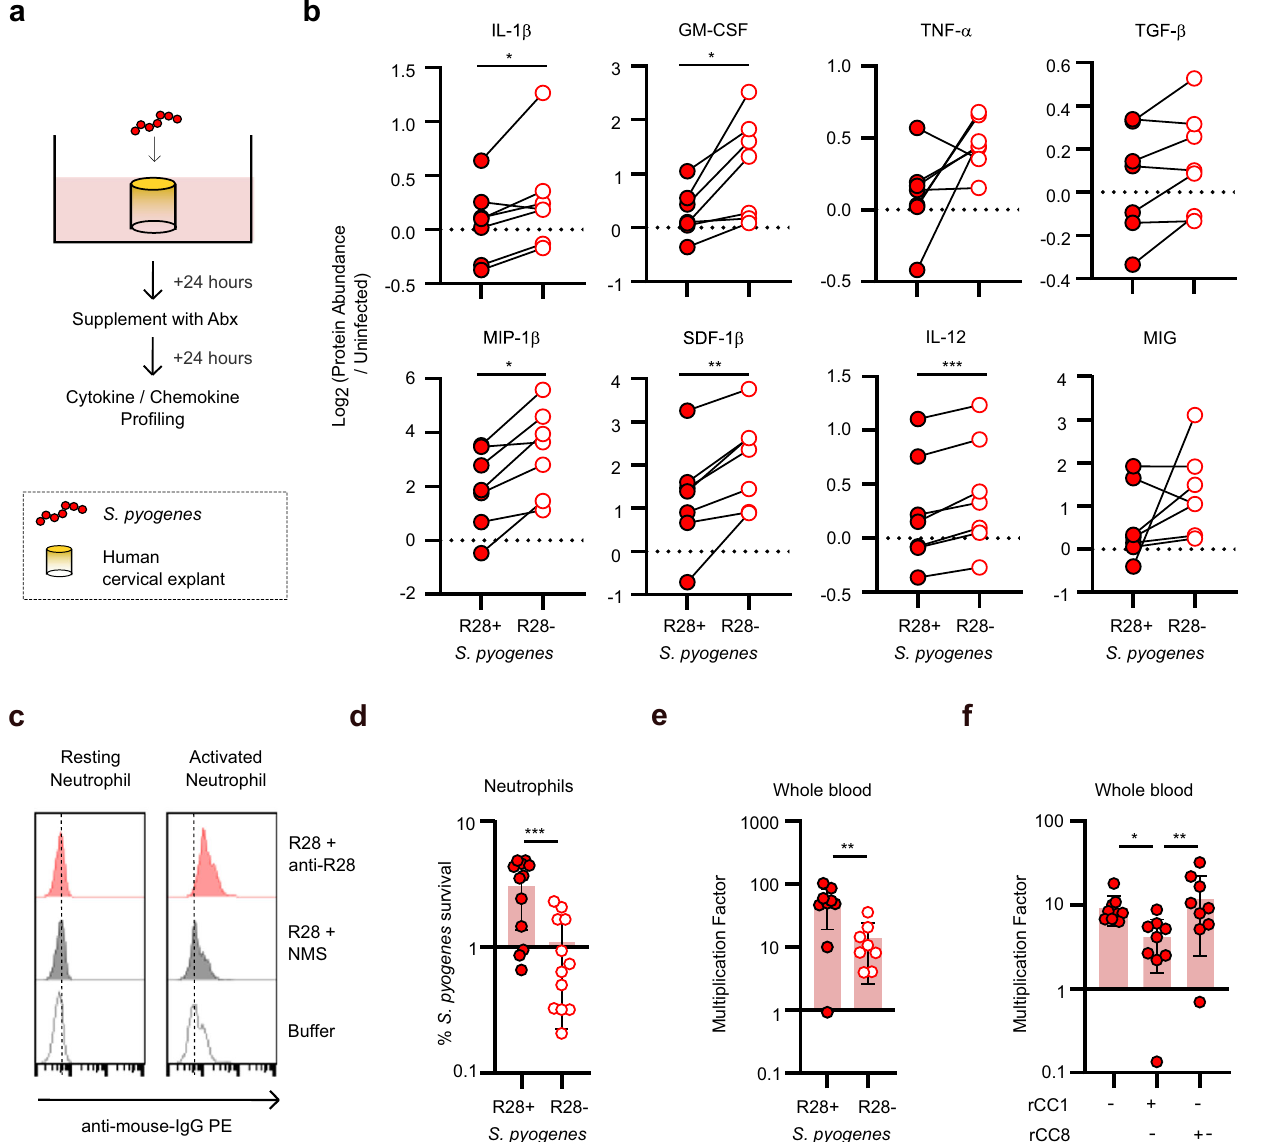
Fig. 5 | S. pyogenes impairs the human immune response through R28- CEACAM1 interaction. a Schematic representation of measurement of the cyto- kine and chemokine response of human cervical explants upon challenge with S. pyogenes strains or control buffer. b Quanti fi cation of the protein level produc- tionofcytokinesandchemokinesbywoundedhumancervicalexplantsinresponse to infection with S. pyogenes strains. Samples were normalized against uninfected controls. Mean and s.d. from n =7 independent human ecto-cervical explant donors. Statistical signi fi cance tested by two-tailed paired Student ’ s t test (IL-1 β * p =0.0334, GM-CSF * p =0.0155, MIP-1 β * p =0.0139, SDF-1 β ** p =0.0075, IL-12 *** p =0.0006). c Activated human neutrophils bind puri fi ed R28. Data is repre- sentative of n =3 independent replicates. d Survival of S. pyogenes after 2h of